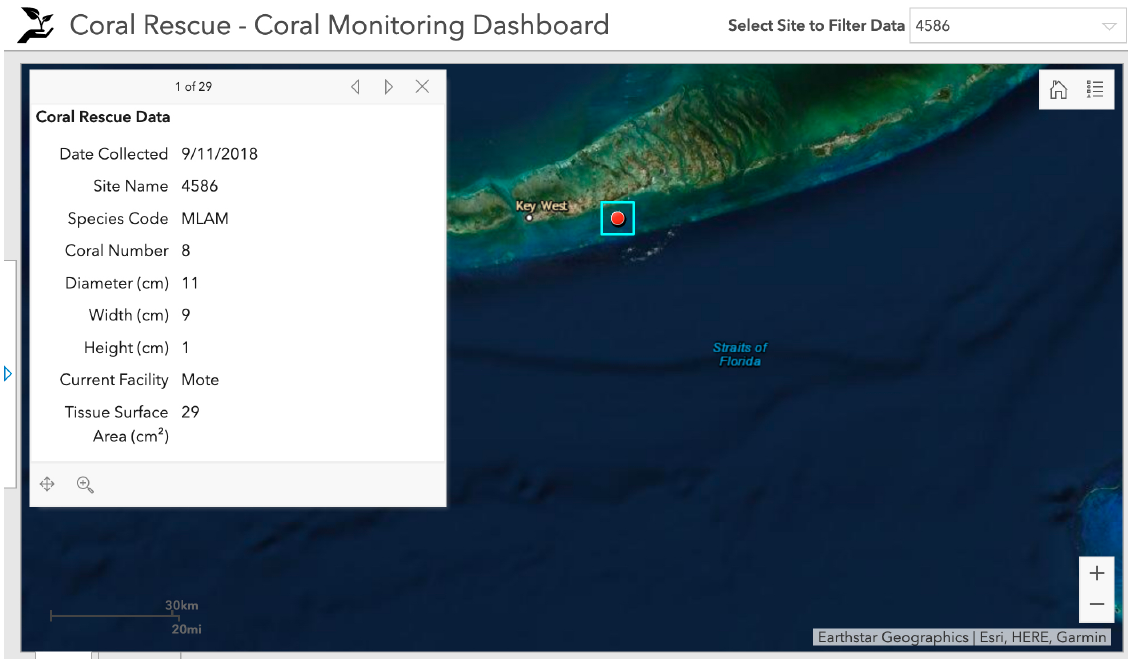
Figure 7: Coral Monitoring Dashboard, search site to filter data to site 4586. Map expanded and field site window opened to coral no. 8. Screenshot captured August 1, 2020. Source: FWC Fish and Wildlife Research